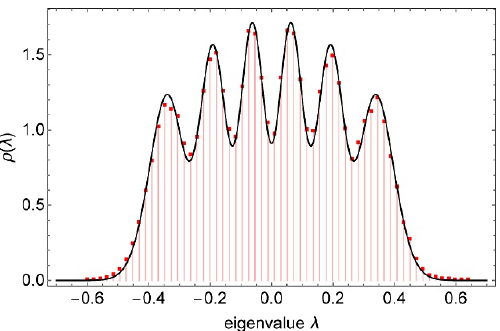
Figure 2 . The histogram of the distributions (cid:26) eig in the SO(6) sector for N = 6 (top) and h = 0 : 3. The solid black line is the matched TGU distribution. vol( E ) (cid:25) 10 5